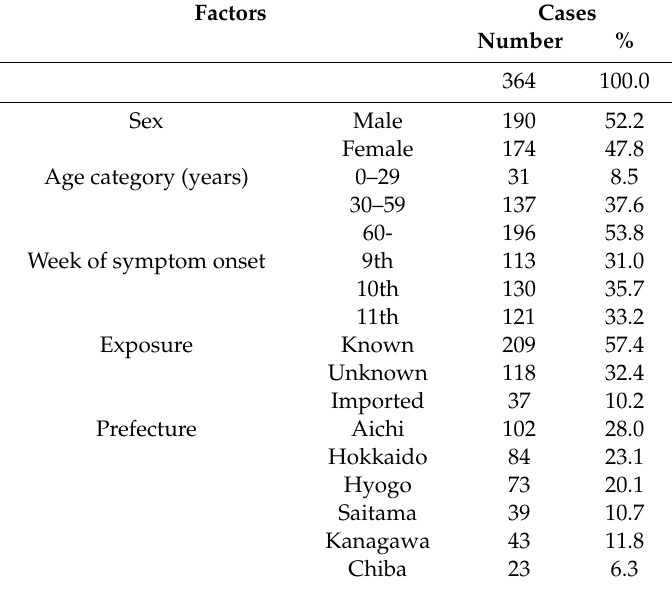
Table 1. Characteristics of symptomatic COVID-19 cases in Study